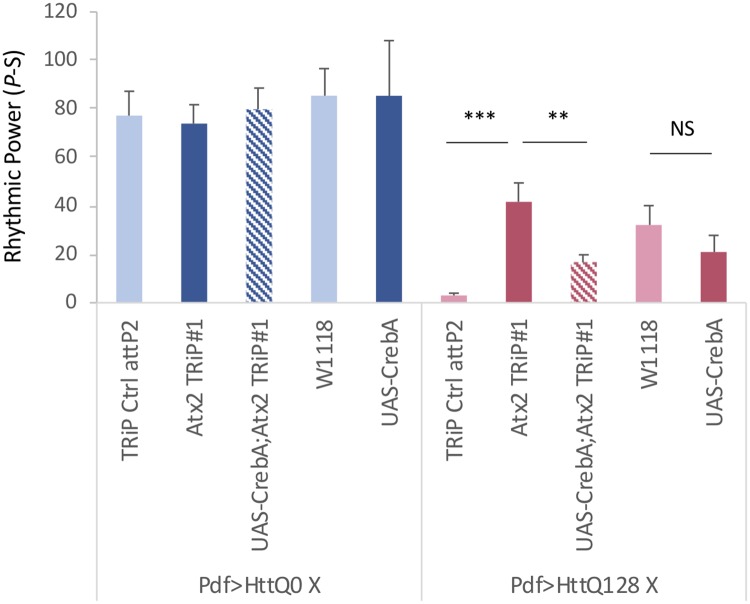
CREBA overexpression partially blocks the rescue of mHtt toxicity by Atx2 knockdown.Rhythmic power (P-S) is indicated for various genotypes including flies expressing HttQ0 (Pdf>HttQ0 in blue) or HttQ128 (Pdf>HttQ128 in red) in PDF neurons in control background (TRiP Ctrl attP2 or W1118) and expressing a Atx2 TRiP RNAi line (Atx2 TRiP#1) or a CREBA overexpression line (UAS-CrebA) or the combination of both (UAS-CrebA; Atx2 TRiP#1; n = 15–40; *p<0.05, **p<0.01, ***:p<0.005, error bars represent standard error).